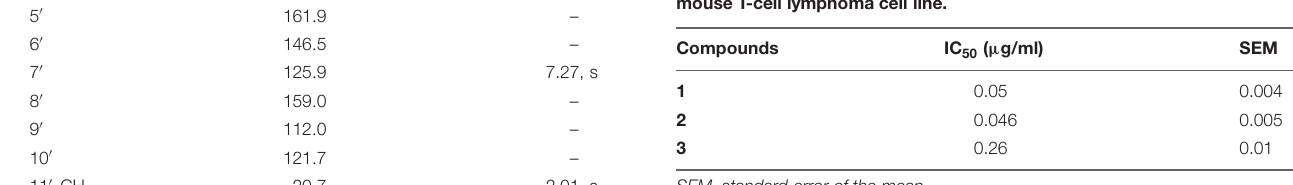
TABLE 4 | Antiproliferative effects of compounds 1–3 on the L5178Y mouse T-cell lymphoma cell